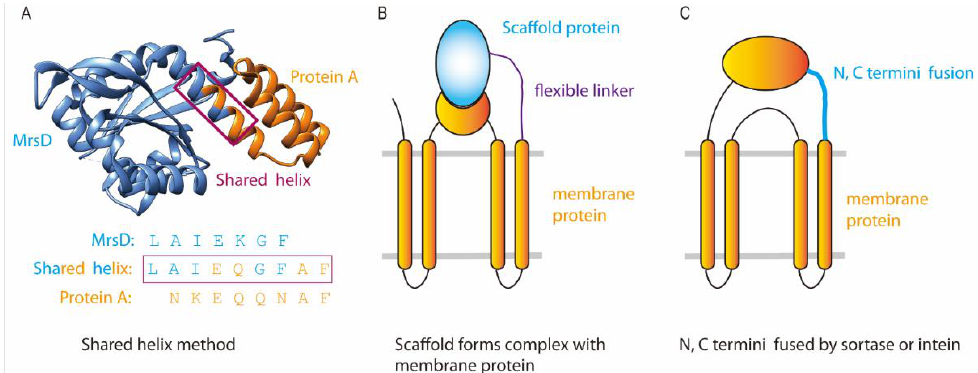
Figure 4. Protein fusion with shared helix, interaction partner and circular connection. Scaffold proteins are colored in blue and the target proteins in orange. ( A ) The shared helix method generates rigid linker connection. In the two connecting helices, residues forming native interactions in each fused protein are kept in the sequence of the shared helix (blue from NrsD and orange from protein A). ( B ) Interaction partners of the target membrane protein are used as the scaffold protein. ( C ) Membrane protein with a soluble domain is termini connected to generate a circular protein.